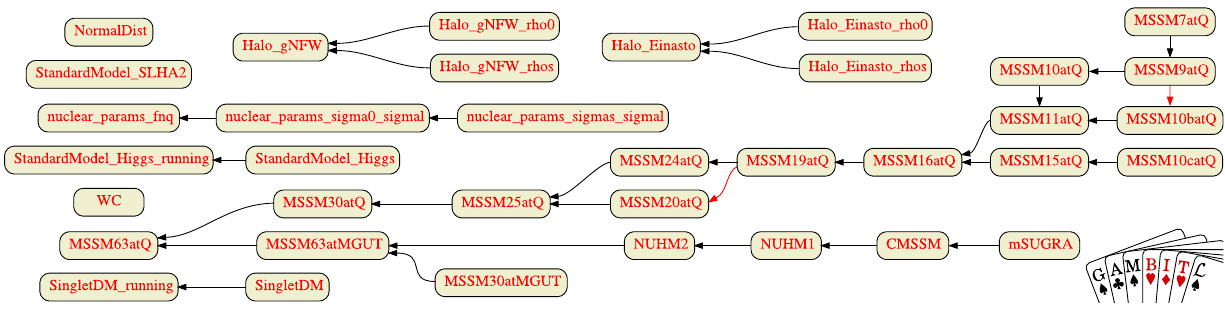
els . Friend translations can cross between otherwise disconnected fam- ily trees, or, as in these two examples, between different branches of the same tree. Graphs like this (including any additional user-specified models)canbegeneratedbyrunning gambit models fromthecom- mand line, and following the instructions provided